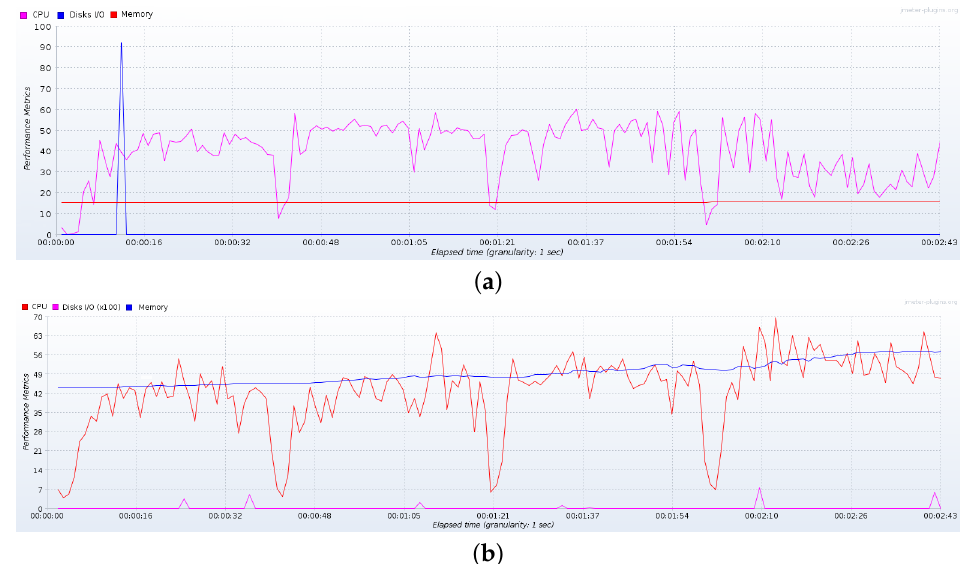
Figure 14. Distributed deployment: Resource utilization reported by ( a ) MongoDB and ( b ) to workers for the task “Enrollment”.